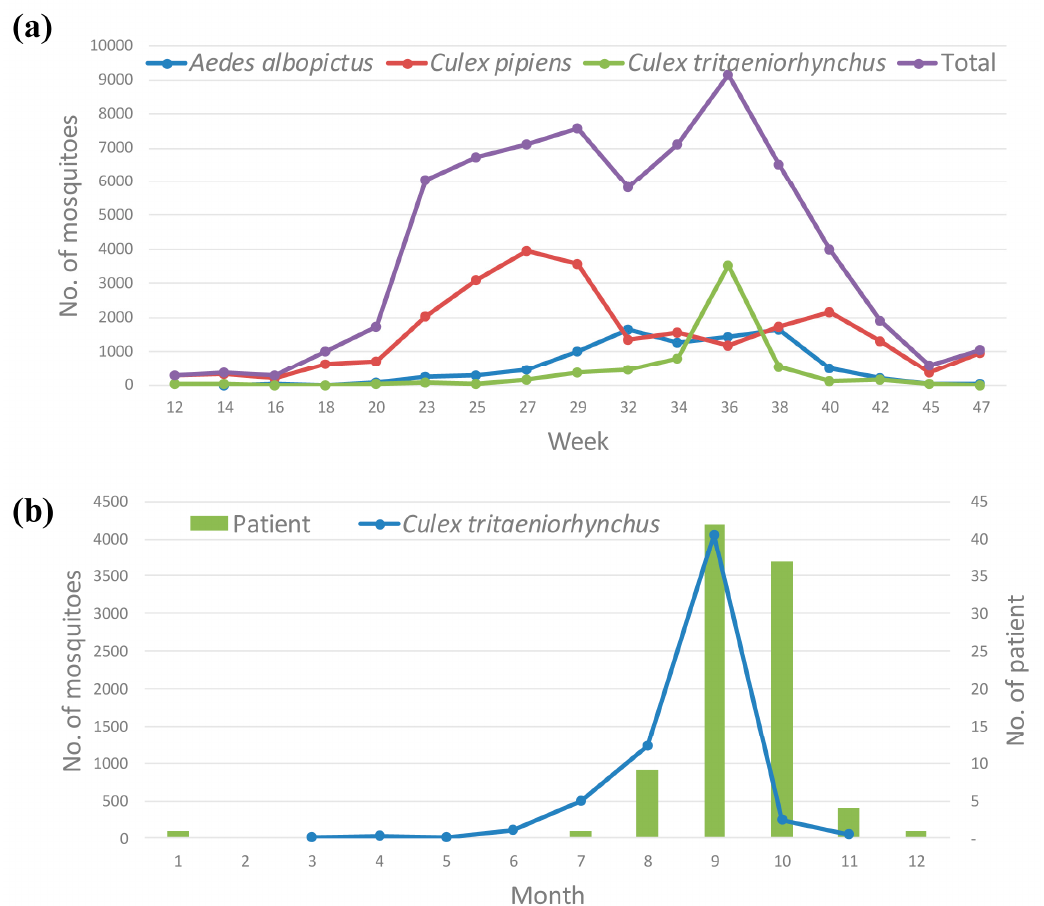
Figure 2. ( a ) Temporal distribution of the populations of the three main mosquito species carrying flavivirus, individually and combined; ( b ) monthly fluctuations in accumulated Japanese encephalitis cases from 2016 to 2020, and Culex tritaeniorhynchus harboring Japanese encephalitis virus in the Republic of Korea in 2020.